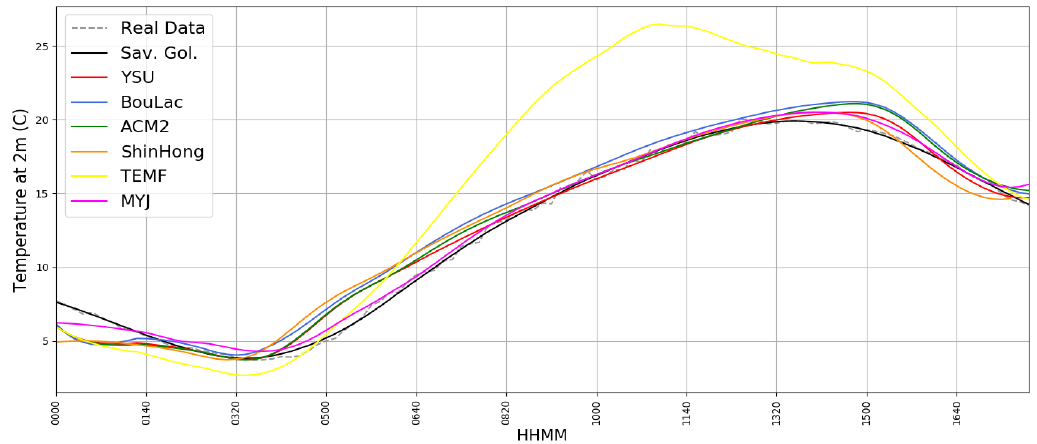
Figure 11. Simulated T2M timeseries compared with real GL T2M timeseries, 04 / 04 / 2016, dotted grey: real data, black: Savitsky–Golay smoothing of real data, red: simulated data with YSU parametrization, blue: simulated data with BouLac parametrization, green: simulated data with ACM2 parametrization, orange: simulated data with ShinHong parametrization, yellow: simulated data with TEMF parametrization, purple: simulated data with MYJ parametrization.